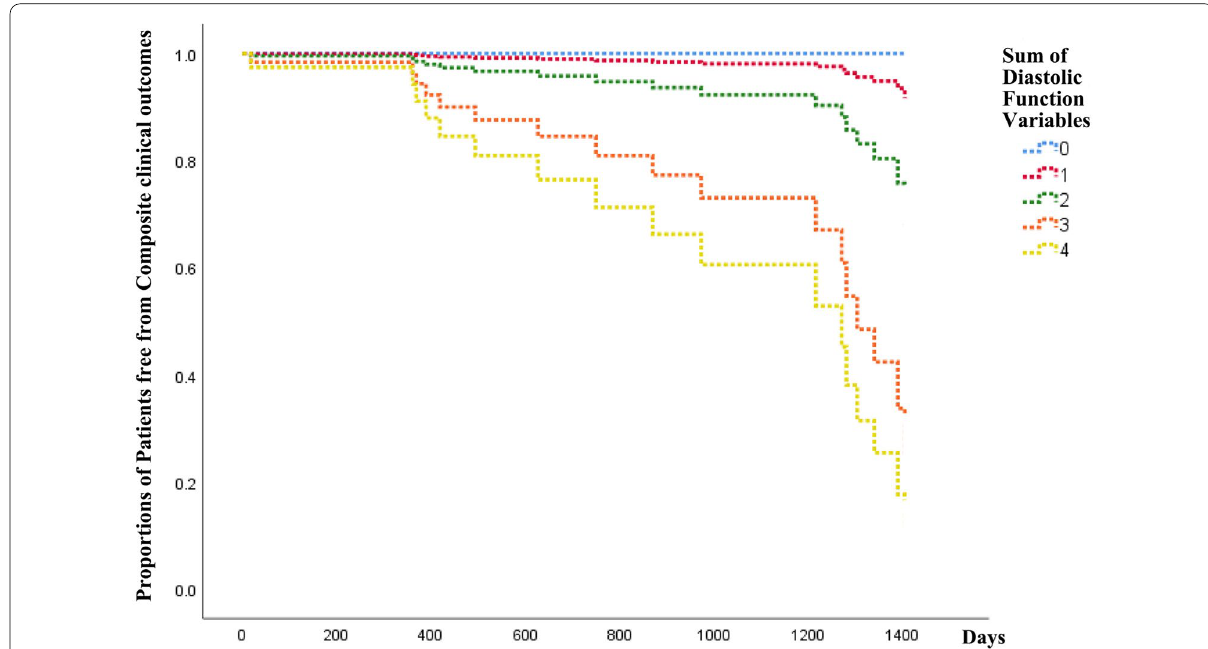
Fig. 2 Cox proportional hazard model showing the proportions of patients free from composite clinical outcomes associated with diastolic dysfunction